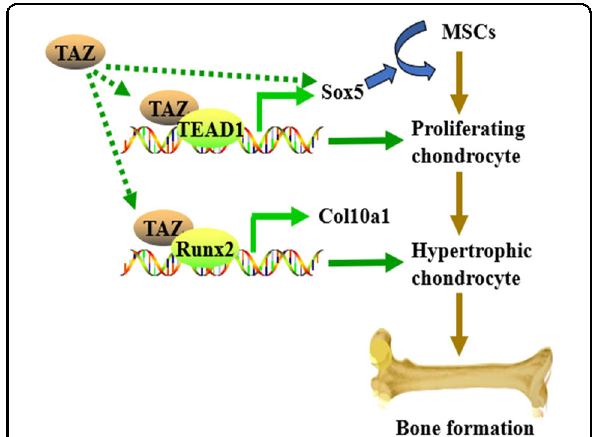
Fig. 8 A schematic presentation of the functions of TAZ on endochondral ossi fi cation and osteoarthritis development. TAZ promotes the proliferation and differentiation of chondrocytes by regulating the expression and stability of Sox5, and enhances chondrocyte maturation by regulating the Col10a1